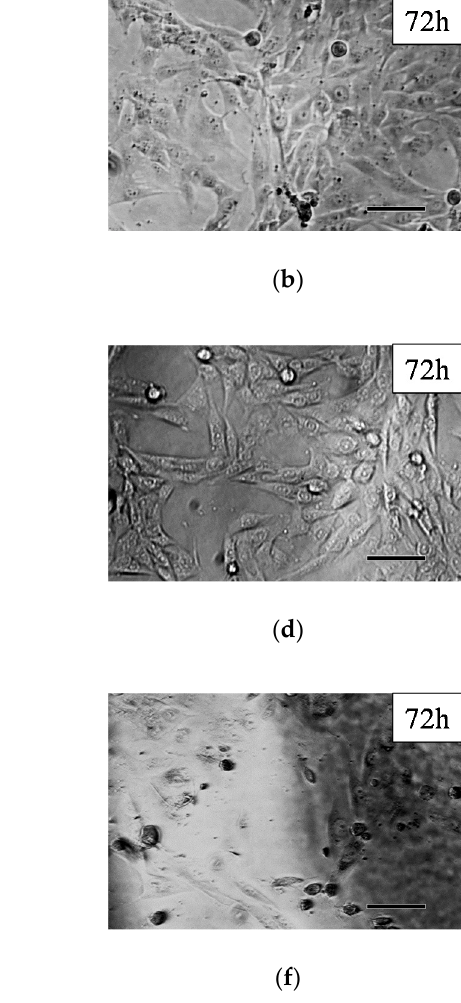
Figure 5. Phase-contrast microscopical images of MG-63 cells: controls after 24 ( a ) and 72 h ( b ), PASP control after 24 ( c ) and 72 h ( d ), and PSI-AAmp after 24 ( e ) and 72 h ( f ) incubation. Scale bars represent 100 μ m.